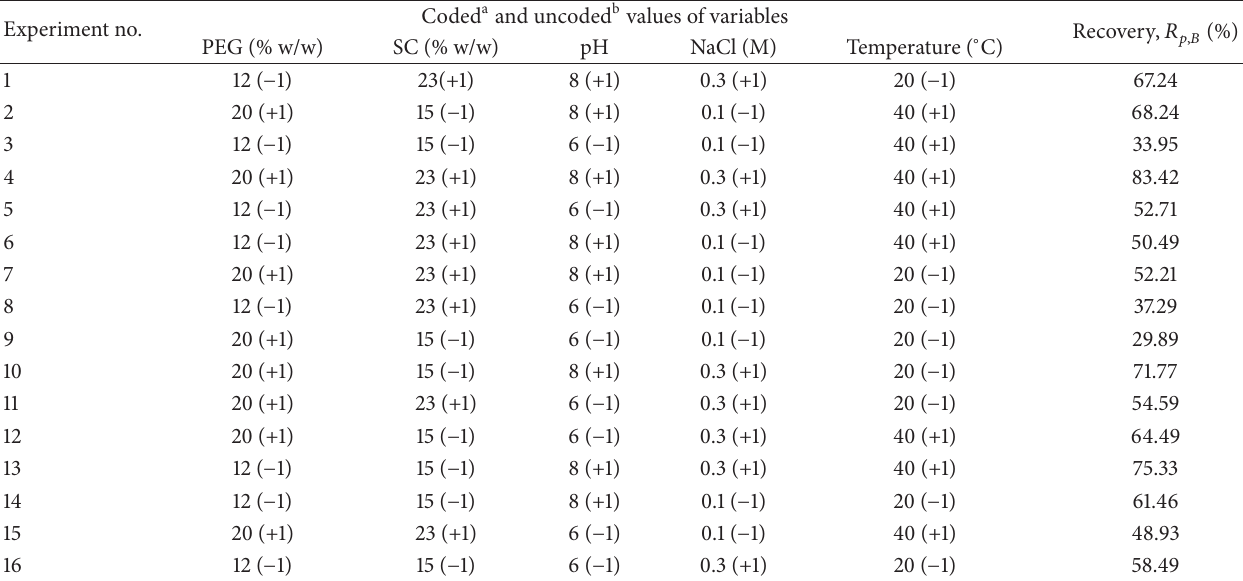
Table 1: Coded and uncoded values of factors of 2 5−1 fractional factorial design (fFD). Experiment no.